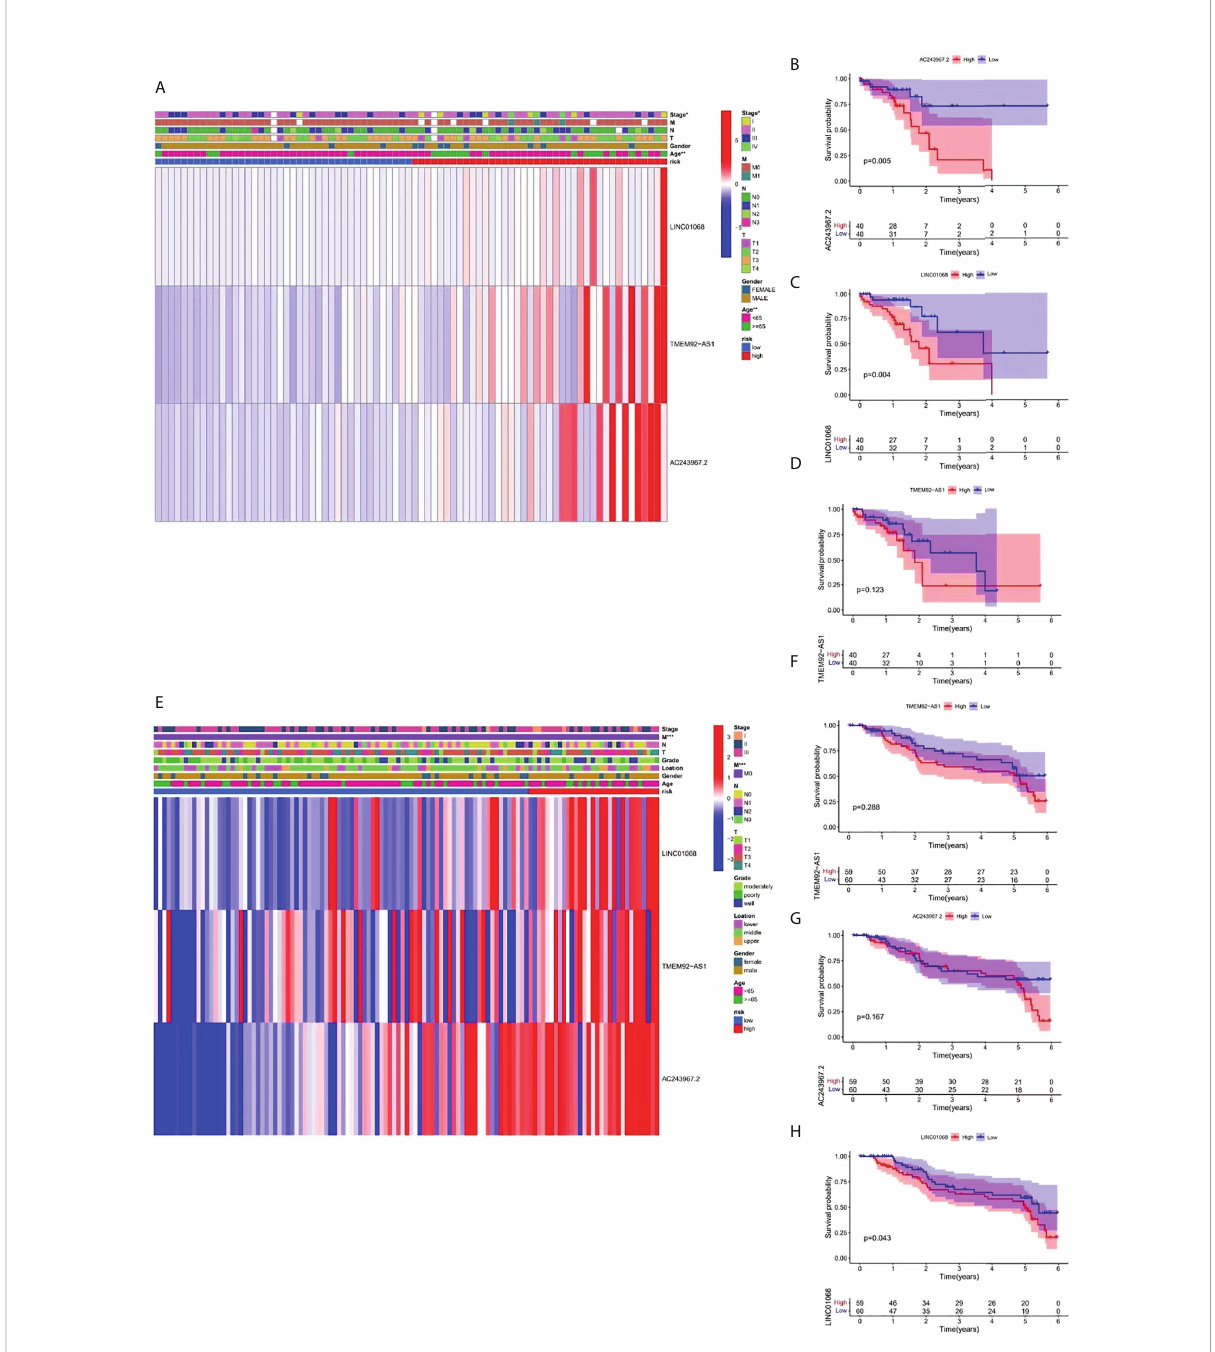
FIGURE 6 Survival analysis and clinical correlation analysis of FIRLs in risk strati fi cation. (A) A composite heat map containing clinical information and expression of 3 FIRLs in TCGA cohort. (B-D) Survival analysis of FIRLs participating in risk strati fi cation in TCGA cohort. (E) A composite heat map containing clinical information and expression of 3 FIRLs in the GEO cohort. (F – H ) Survival analysis of FIRLs participating in risk strati fi cation in the GEO cohort. * P <0.05, ** P <0.01, *** P